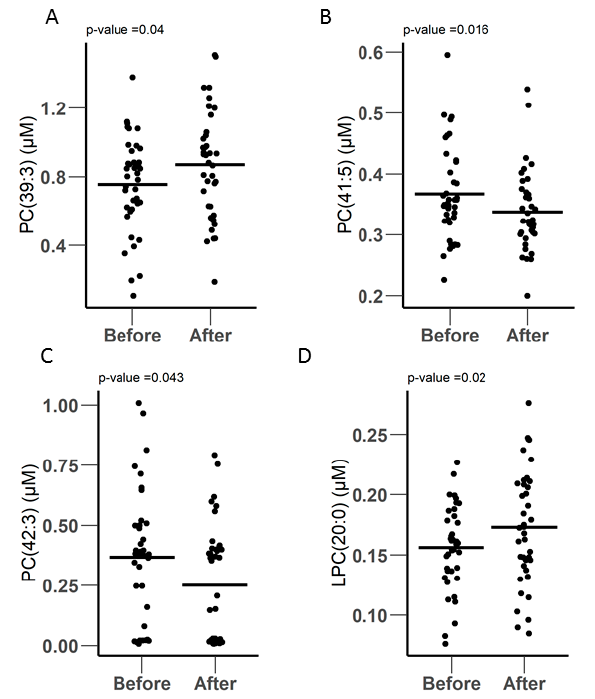
Figure 4. ( A – C ) Differentially expressed PCs and ( D ) LPC before and after surgery, as measured by LC-MS using the biocrates P400 kit.